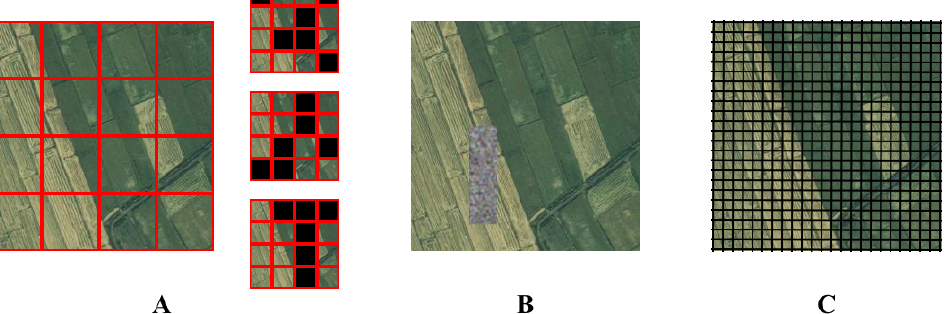
Figure 2. Data pre-processing methods. ( A ) is Remote Erasing; ( B ) is Puzzle Block; ( C ) is Stockade